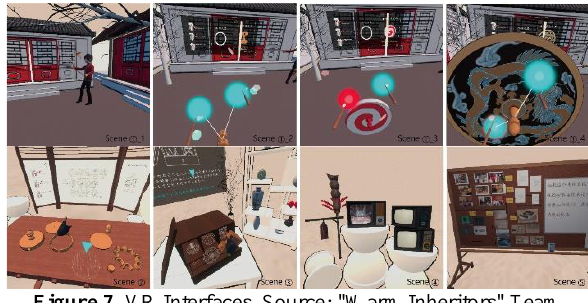
Figure 7 . VR Interfaces. Source: "Warm Inheritors"